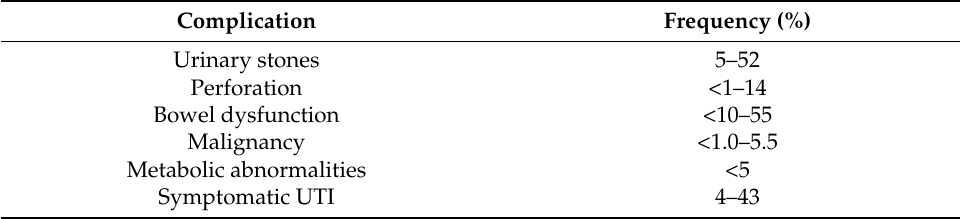
Table 1. Complications after augmentation